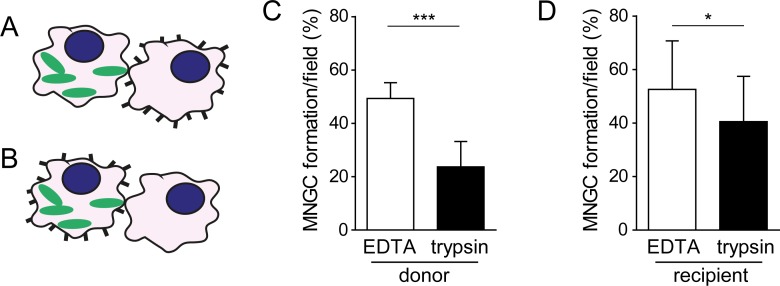
Proteins located specifically on the surface of both donor (infected) and recipient (neighboring uninfected) RAW264.7 macrophages contribute to MNGC formation induced by B. thailandensis.A) and B) Schematic depicting acute protease treatment of donor cells and recipient cells, respectively. Green shapes indicate bacteria and black bars represent surface proteins. C) Macrophages infected with B. thailandensis at MOI 33 for approximately 6 h were treated with trypsin or EDTA for 30 min. Detached cells were mixed at equal ratios with uninfected and untreated macrophages and seeded at 6×105 cells per well in a 24 well plate using agarose overlay assay. After incubating the cells for 3–4 h MNGC formation was quantified. Data represent the mean + SD of two independent experiments performed in duplicate. ***, P < 0.0001 (t-test)/effect size: 3.226 (Hedges’ g). D) Macrophages were infected with B. thailandensis at MOI 33 for approximately 6 h and mixed with trypsin or EDTA treated uninfected cells at equal ratios. The cells were seeded in a 24 well plate at 6×105 cells per well and brought into contact through agarose overlay. Cell-cell fusions were calculated at 3–4 h post seeding. Data represent the mean + SD of three independent experiments performed in duplicate. *, P = 0.0463 (t-test)/effect size: 0.688 (Hedges’ g).